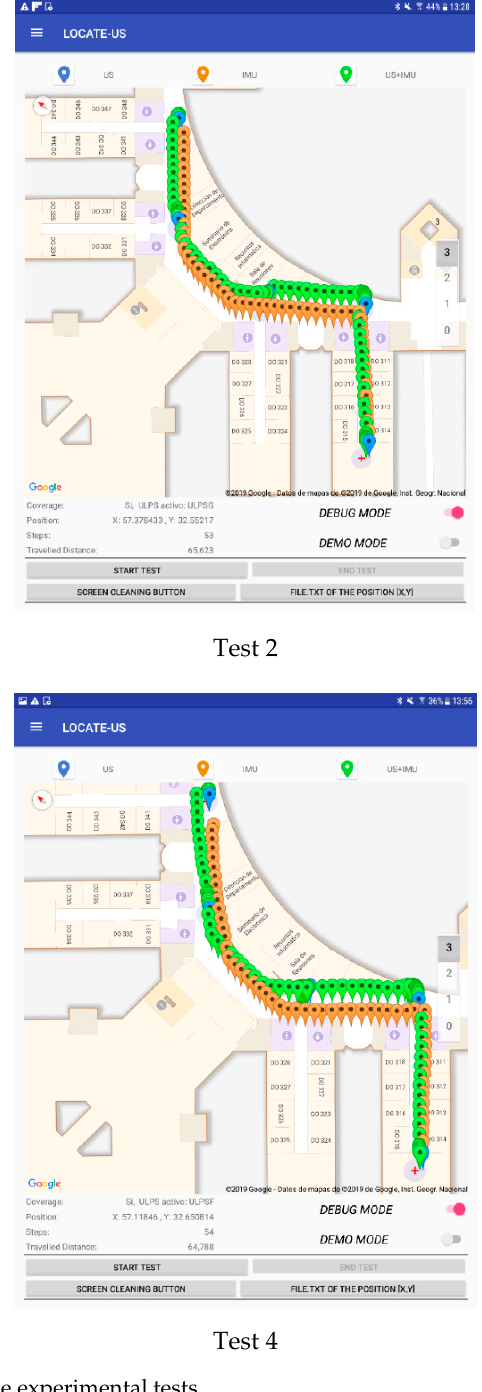
Figure 19. Android screen shots of the experimental